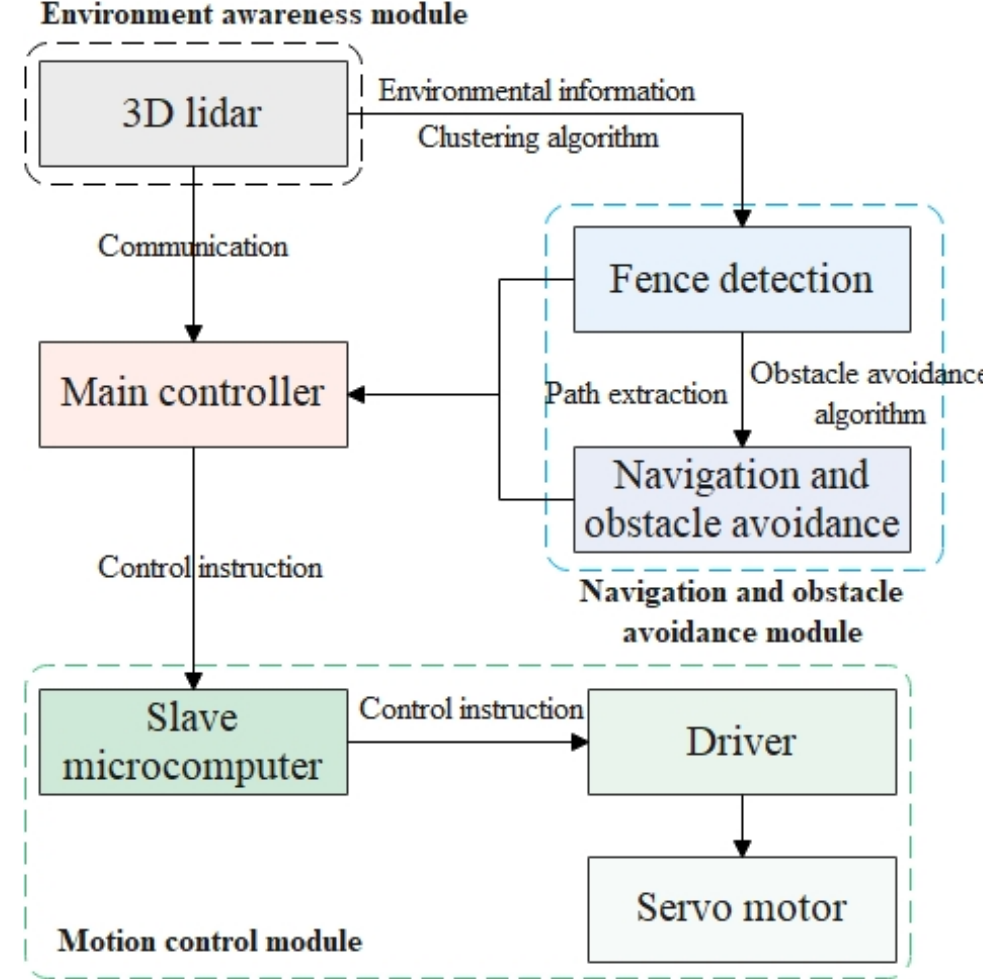
Figure 1. The vehicle navigation hardware system.